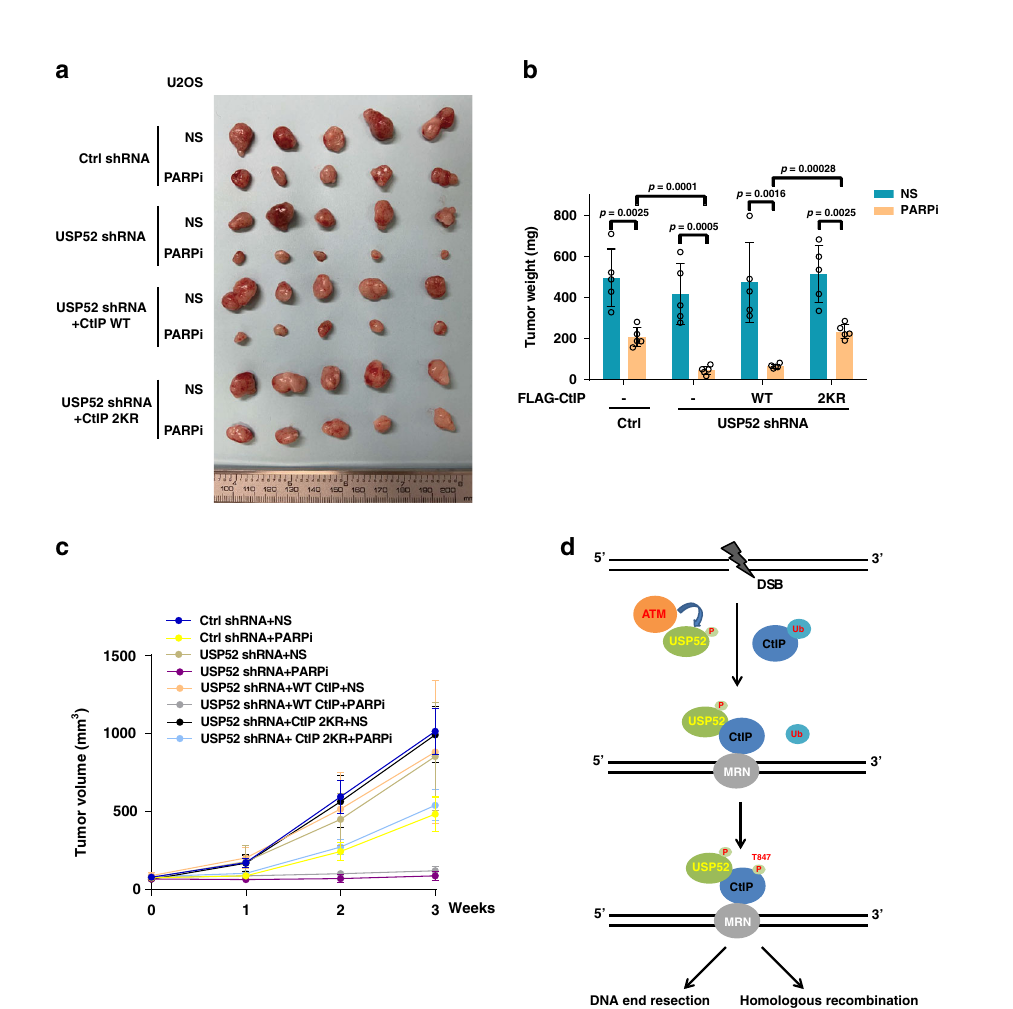
Fig. 6 USP52 – CtIP pathway is critical for enhancing chemotherapy of osteosarcoma cancer cells in vivo. a – c Control or USP52-depleted U2OS cells stably expressing control vector, WT or 2KR mutant of CtIP were subcutaneously injected into the fl ank of NOD-SCID mice. Mice were treated with saline or olaparib (50 mg/kg i.p. 3 days × 6 times). Tumor images ( a ), tumor weight ( b ), and tumor volume ( c ) were then assessed. Data points in represent (mean ± SEM) are shown from n = 5 biologically independent samples by two-sided unpaired t test. d Working model of CtIP regulation by